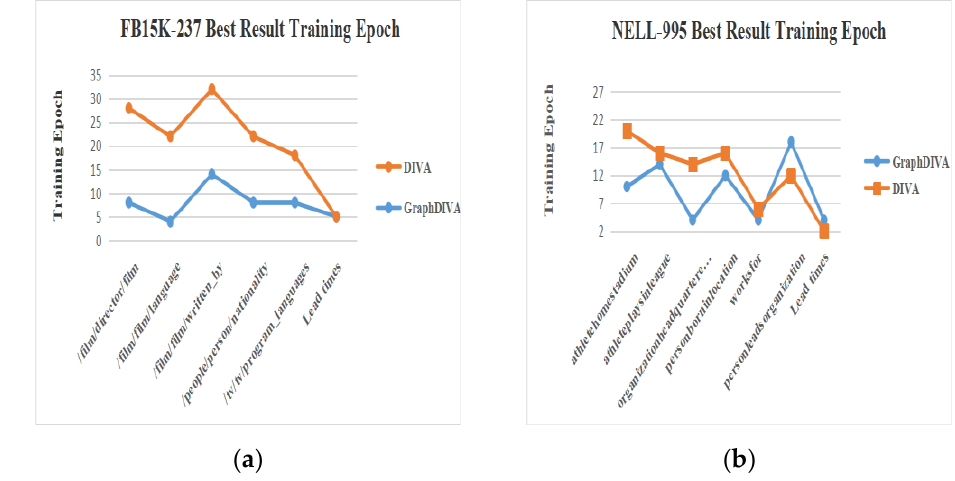
Figure 5. ( a ) Depiction of FB15K-237 best result training epoch; ( b ) depiction of NELL-995 best result training epoch. training